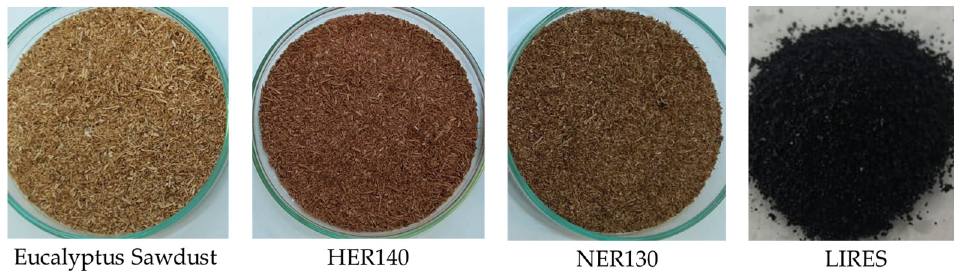
Figure 2. Eucalyptus sawdust before and after sequential acid-alkaline treatment. HER140 repre-